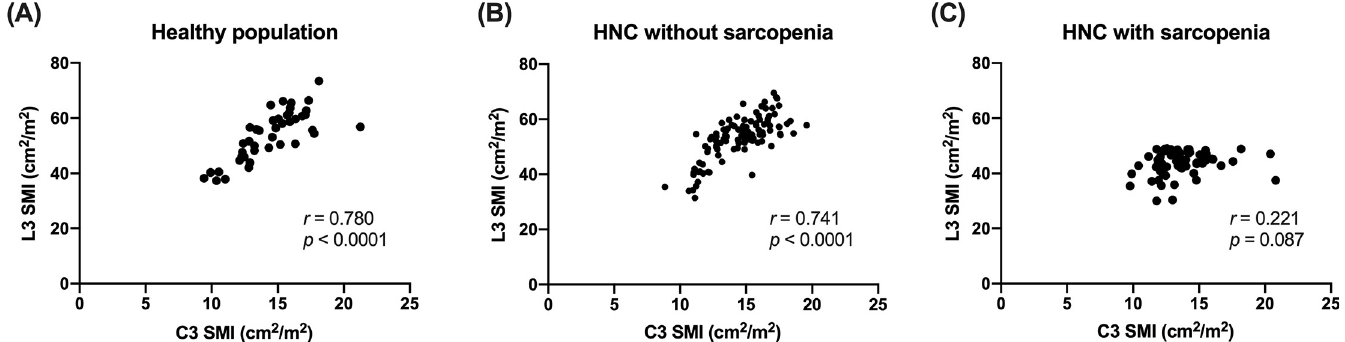
Fig 4. Association between the skeletal muscle index at L3 and that at C3 in each group. SMI, skeletal muscle index; HNC, head and neck cancer.